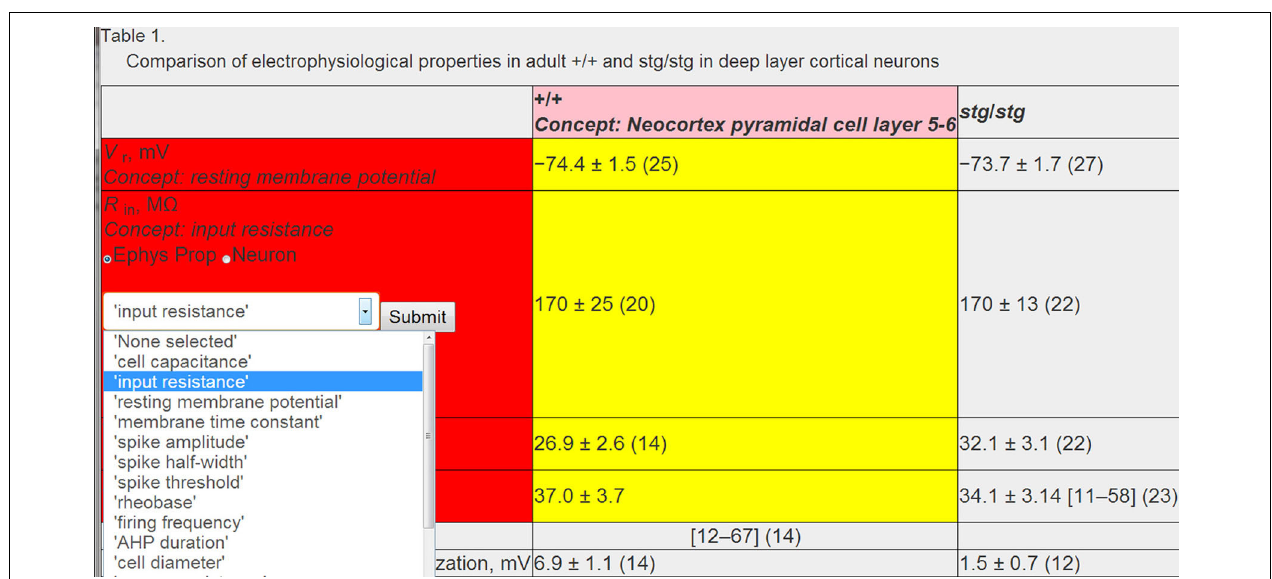
FIGURE 4 | Example of human validation of algorithmically assigned content. All textual elements of a table are enhanced using HTML and javascript to allow for assignment of neuron or electrophysiological